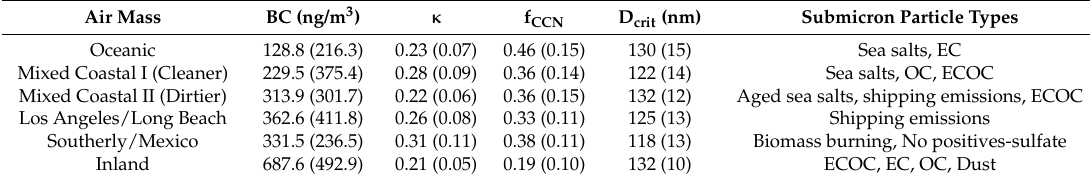
Table 1. Air mass transport conditions, average black carbon (BC) mass concentrations, observed particle types, and average values of κ , f CCN , and D crit observed at 0.17% supersaturation. The standard deviation is given in